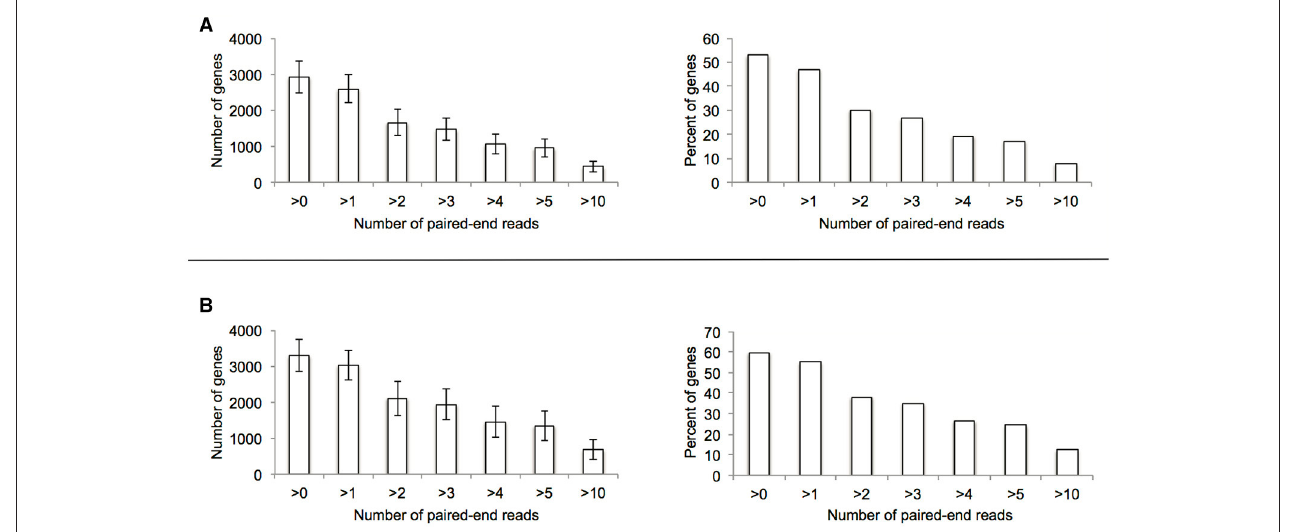
FIGURE 2 | Summary of genome coverage RNA-seq data used for the comparative experiment between wt (A) and 1 alr (B) strains.